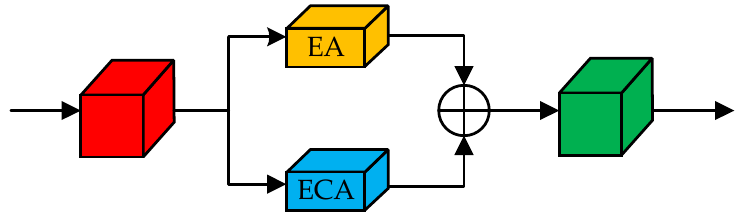
Figure 6. Dual attention module.